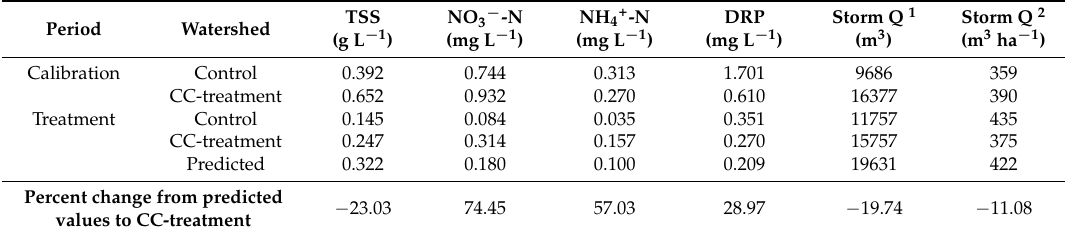
Table 8. Event mean concentrations representing 28 storm events collected during the calibration period from November to May and 8 during the CC-treatment period (Hairy vetch). Predicted values are calculated from the equations in table